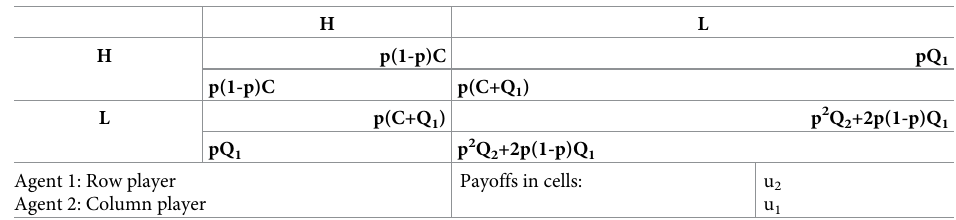
Table 1. Normal form of Austin’s